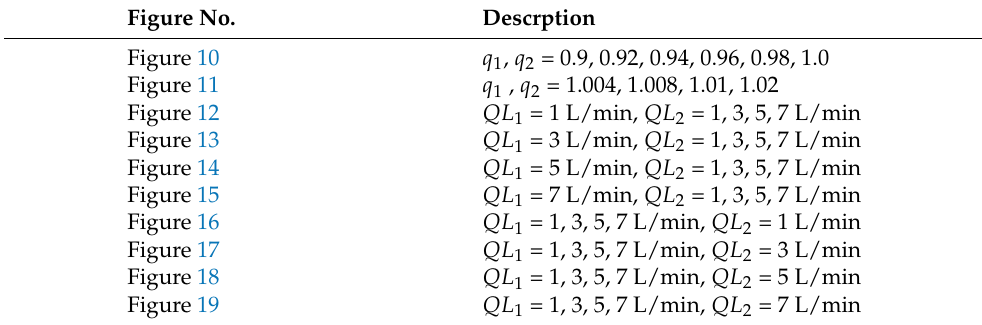
Table 4. The relationships between the output temperature of cold fluid and the volume flow rates of hot fluid, cold fluid for the proposed parallel model for the spiral-plate counter-flow heat exchanger. Figure No. Descrption Figure